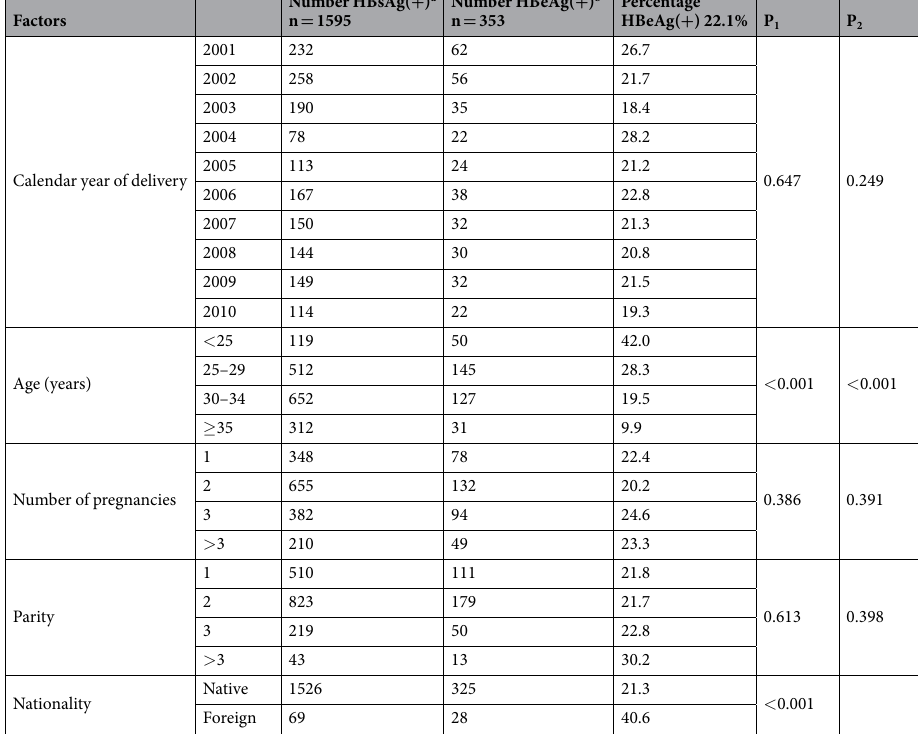
Table 2. Number and prevalence of positive HBeAg rate among HBsAg carrier parturients who delivered from 2001 to 2010. * P 1 . Pearson’s chi-square test; P 2 . chi-square test for linear trend. a Number of deliveries from 1256 HBsAg-positive mothers. b Number of deliveries from 263 HBeAg-positive mothers.